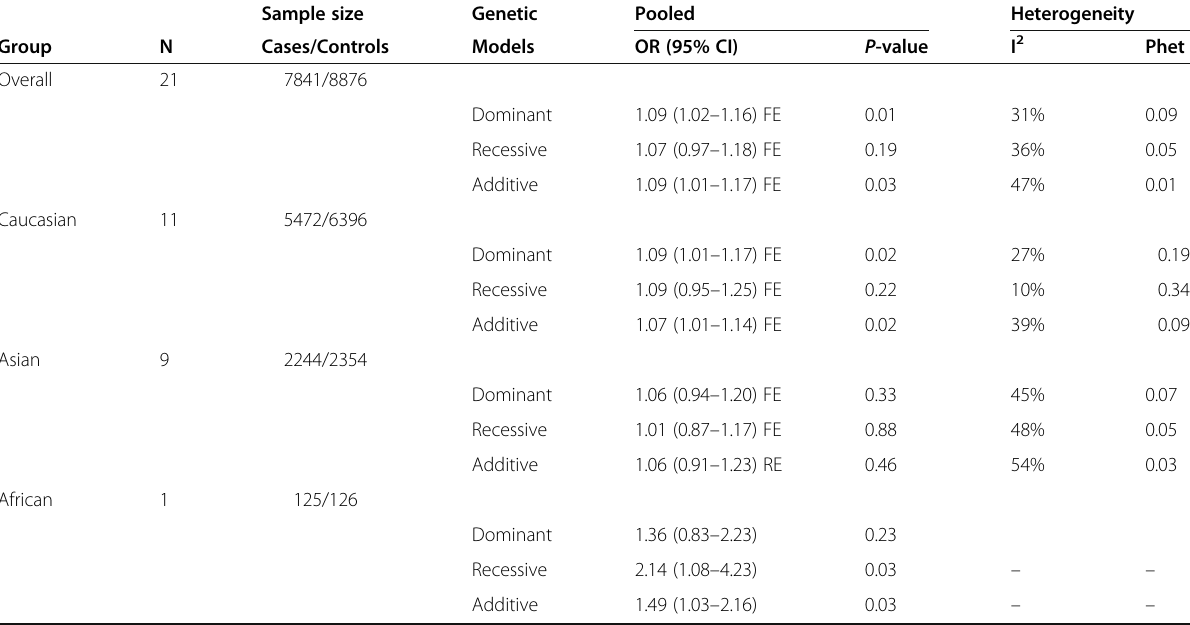
Table 2 Distribution of TP53 p.Arg72Pro polymorphism according to the different genetic models Sample size Genetic Pooled